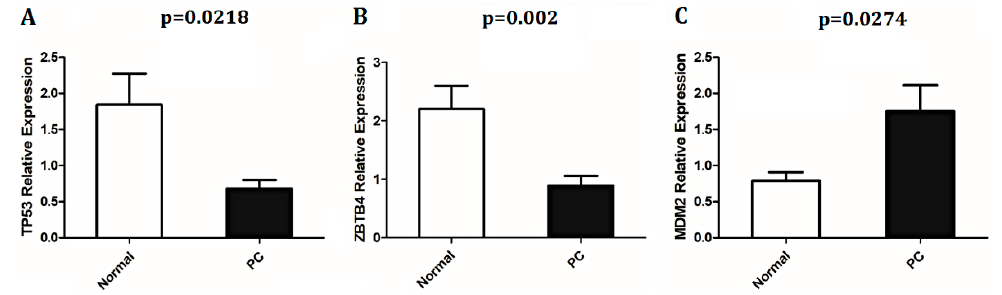
Figure 4. Relative expression (log scale) of TP53 ( A ), ZBTB4 ( B ), and MDM2 ( C ) genes in normal and PC tissues. Data are presented as mean ± SD (standard deviation).